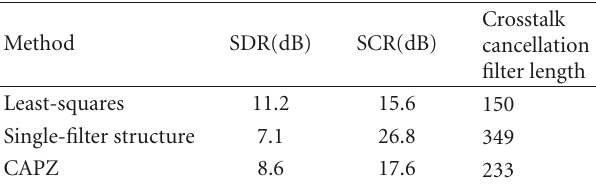
Table 4: Mean crosstalk cancellation performance in the symmetric case for the three methods when the inverse filter length equals 150.